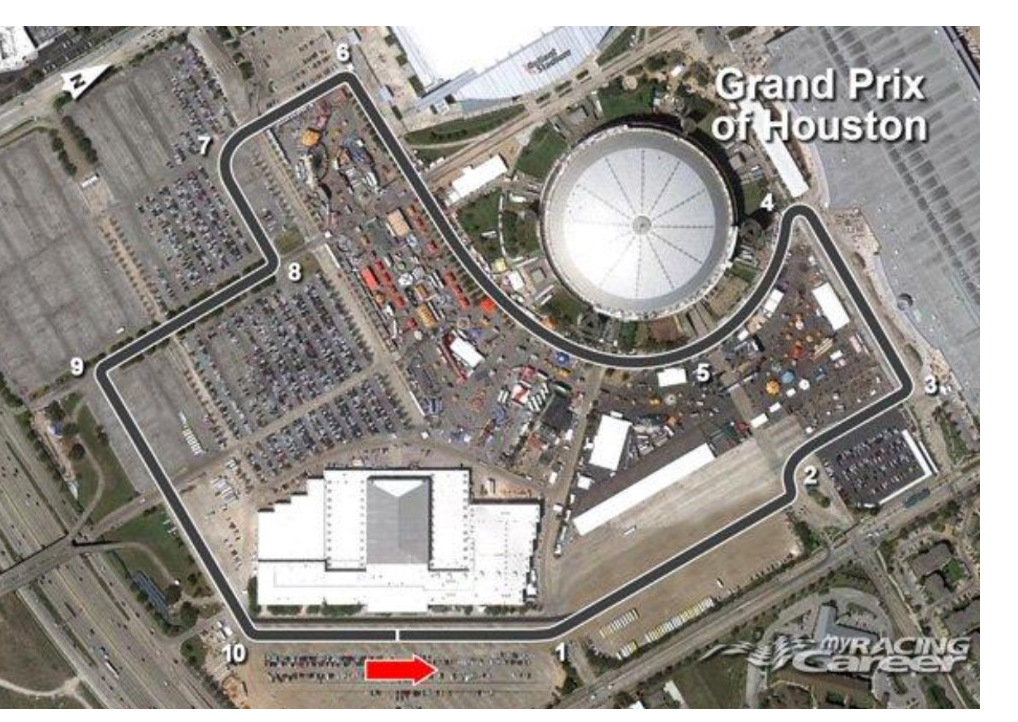
Figure 10. Houston circuit in Texas, USA.